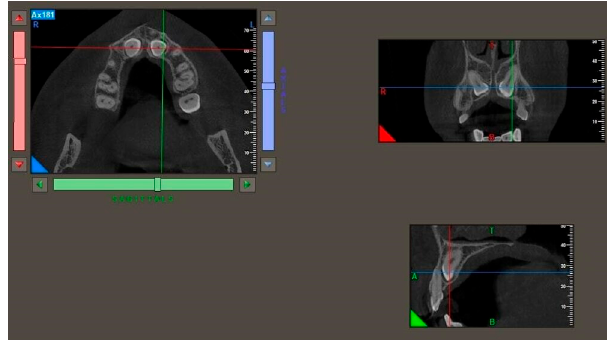
Figure 2. Bilaterally palatally impacted canines.